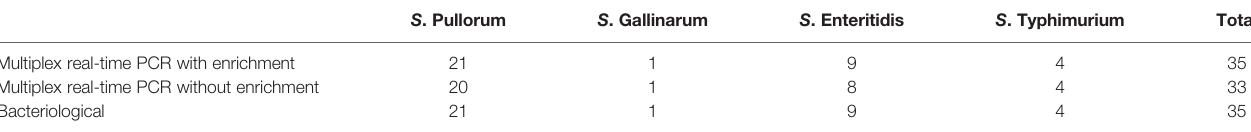
TABLE 3 | Consistency evaluation of the multiplex real-time PCR and conventional bacteriological method for the clinical